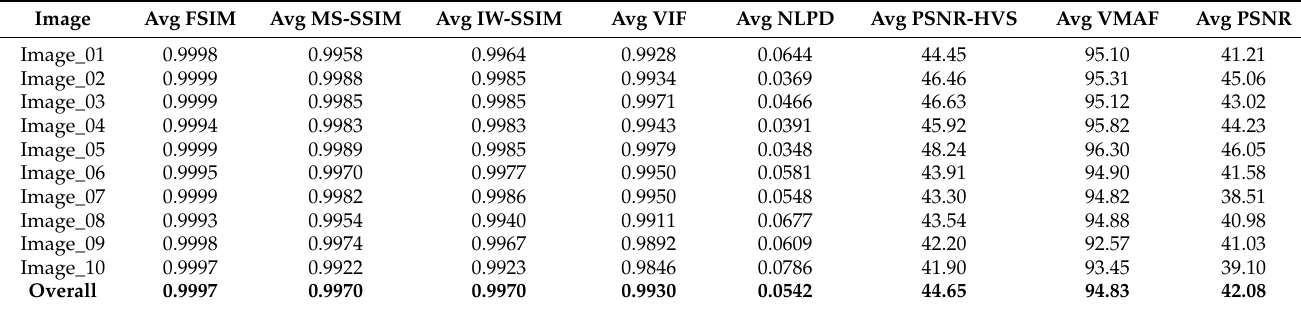
Table 3. The calculated average IQMs for the corresponding images at the point visually lossless compression level in the overall subjective test.